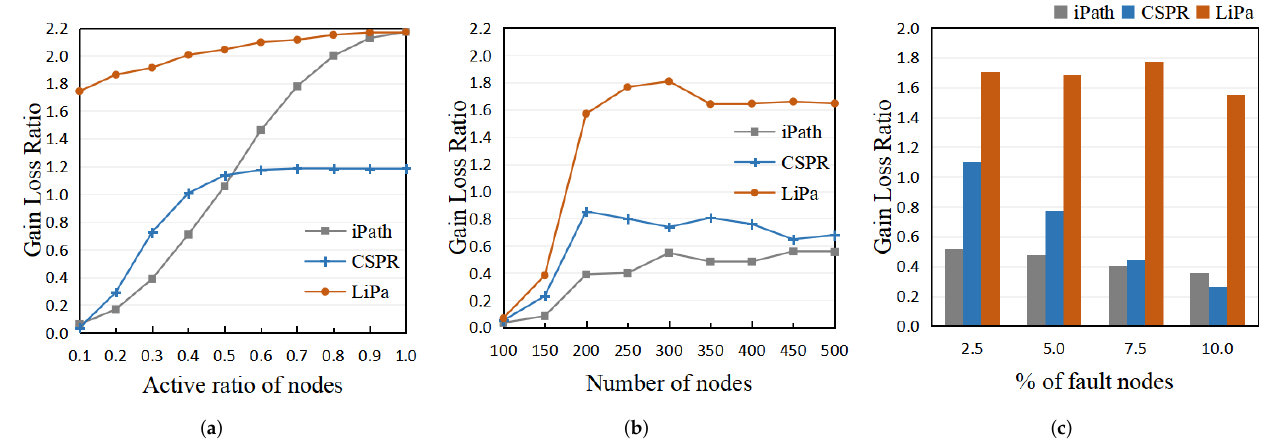
Figure 8. Comparison of the Gain–Loss Ratio: ( a ) Variation in the gain–loss ratio with different node activity; ( b ) Variation in the gain–loss ratio with the number of nodes; ( c ) Variation in the gain–loss ratio with the different node failure